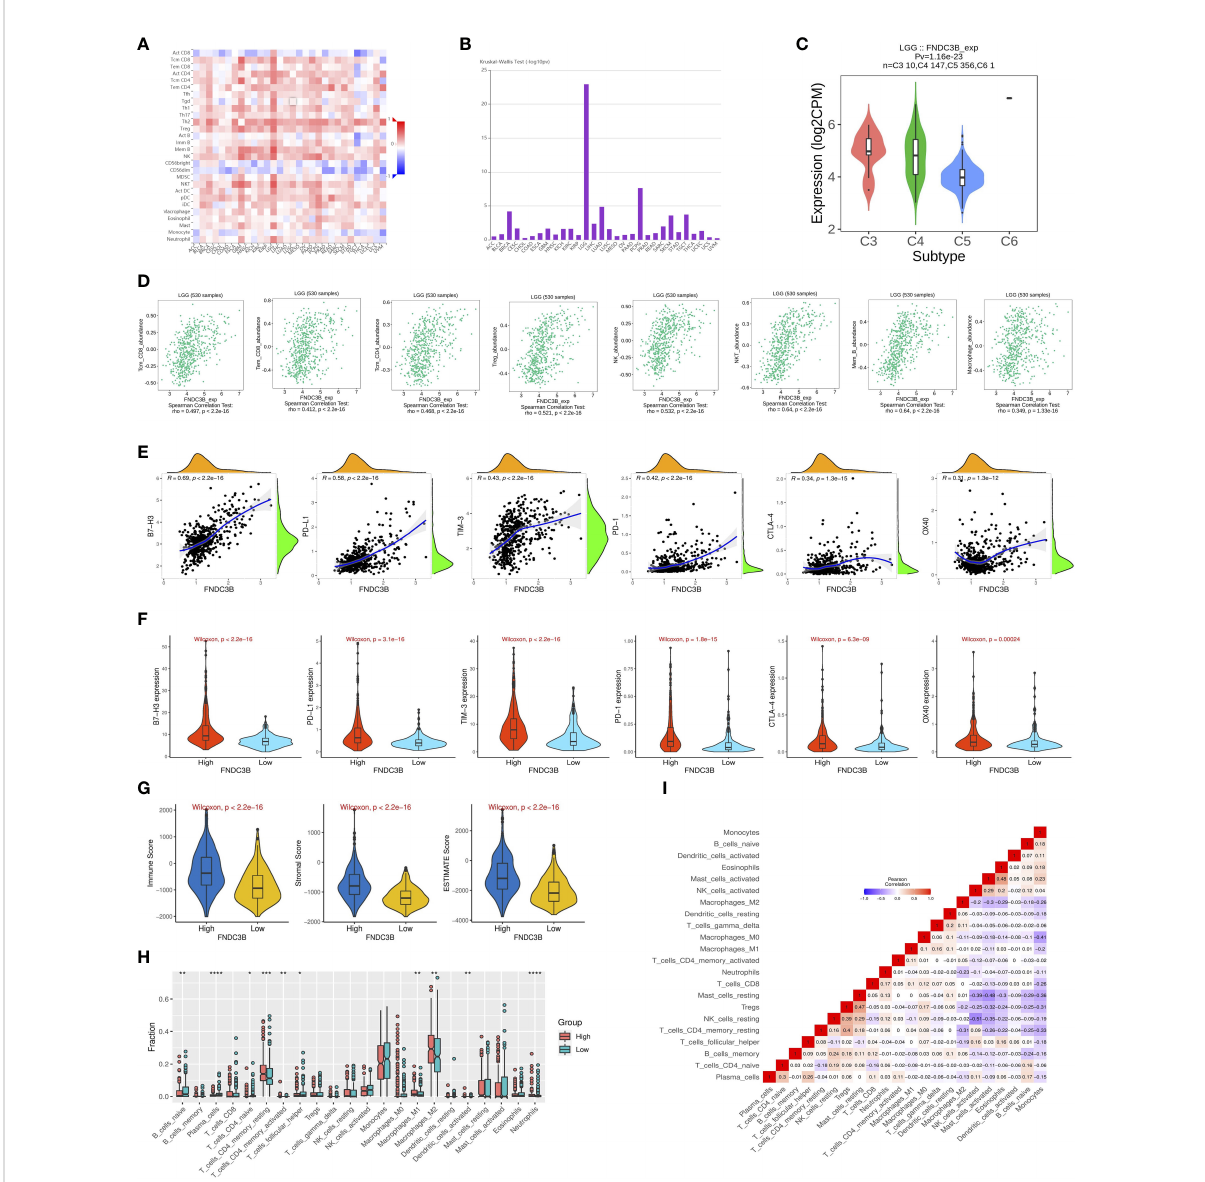
FIGURE 5 Correlation of FNDC3B expression with immune in fi ltration level in pan-cancer and TCGA low-grade glioma (LGG). (A) The landscape of correlation between FNDC3B expression and tumor-in fi ltrating lymphocytes (TILs) in pan-cancer (red is positive correlated and blue is negatively correlated). (B) Associations between FNDC3B expression and immune subtypes across human cancers. (C) Correlation of FNDC3B expression and immune subtypes in low-grade glioma (LGG). C3: in fl ammatory; C4: lymphocyte depleted; C5: immunologically quiet; C6: TGF- b dominant. (D) FNDC3B expression was positively closely related with in fi ltrating levels of central memory CD8 T cells, effector memory CD8 T cells, central memory CD4 T cells, regulatory T cells, natural killer cells, natural killer T cells, memory B cells, and M1 and M2 macrophages in LGG and glioblastoma multiforme (GBM). (E) The correlation between FNDC3B and immune checkpoint molecules (B7-H3, PD-L1, TIM-3, PD-1, CTLA-4, and OX40). (F) Different expression levels of the six immune checkpoint genes in the high and low FNDC3B expression groups in TCGA LGG samples. (G) Comparison of immune, stromal, and ESTIMATE scores between the FNDCB high- and low-expression groups. (H) Different proportions of 22 subtypes of immune cells in the FNDCB high- and low-expression groups in TCGA LGG dataset by CIBERSORTx. The proportions of naive B cells (P < 0.01), plasma cells (P < 0.0001), naive CD4 T cells (P < 0.05), resting memory CD4 T cells (P < 0.001), activated memory CD4 T cells (P < 0.01), follicular helper T cells (P < 0.05), macrophages M1 (P < 0.01), macrophages M2 (P < 0.01), dendritic cells activated (P < 0.01), neutrophils (P < 0.0001). *P < 0.05, **P < 0.01, ***P < 0.001, ****P < 0.0001. (I) Correlation matrix heatmap of 22 immune in fi ltration cells in LGG